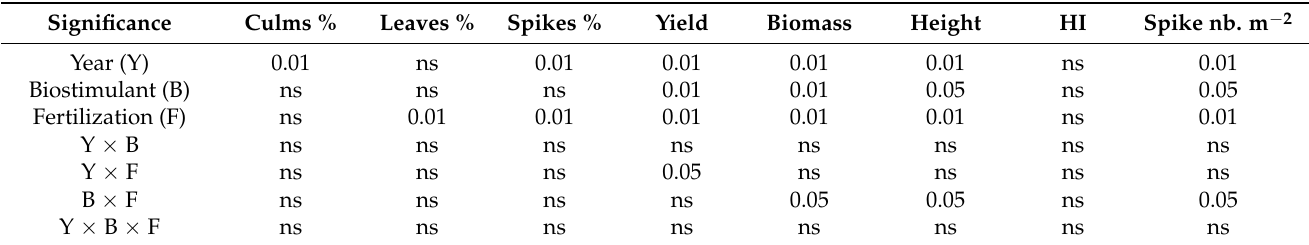
Table 2. Statistical analysis (significance ( p value) and interaction) of growth parameters, yield and its